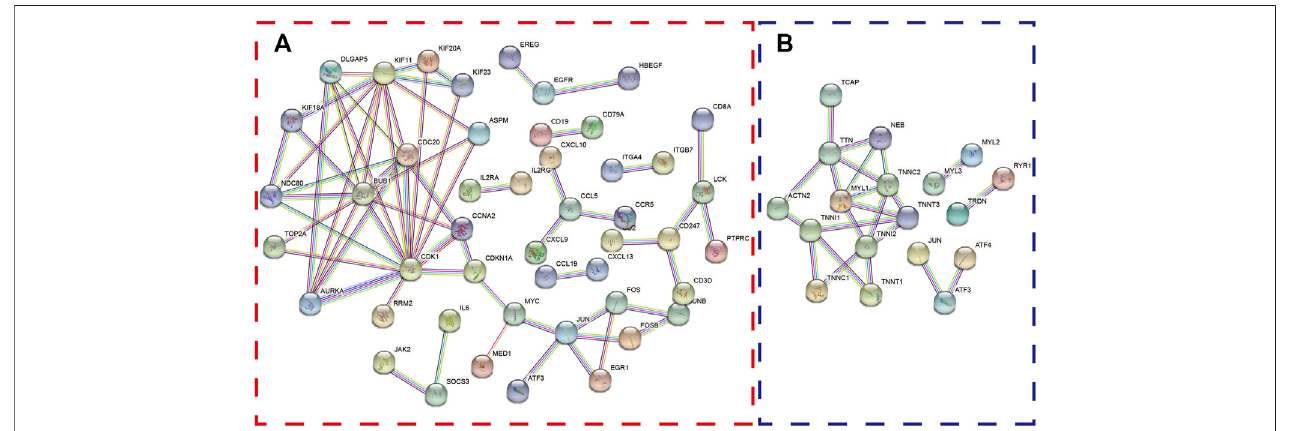
FIGURE 3 | The protein – protein interaction (PPI) network was constructed with differentially expressed genes. The PPI network shows the interactions among genes with a minimum required interaction score > 0.99 in the GPL96 database (A) and GPL570 database (B)